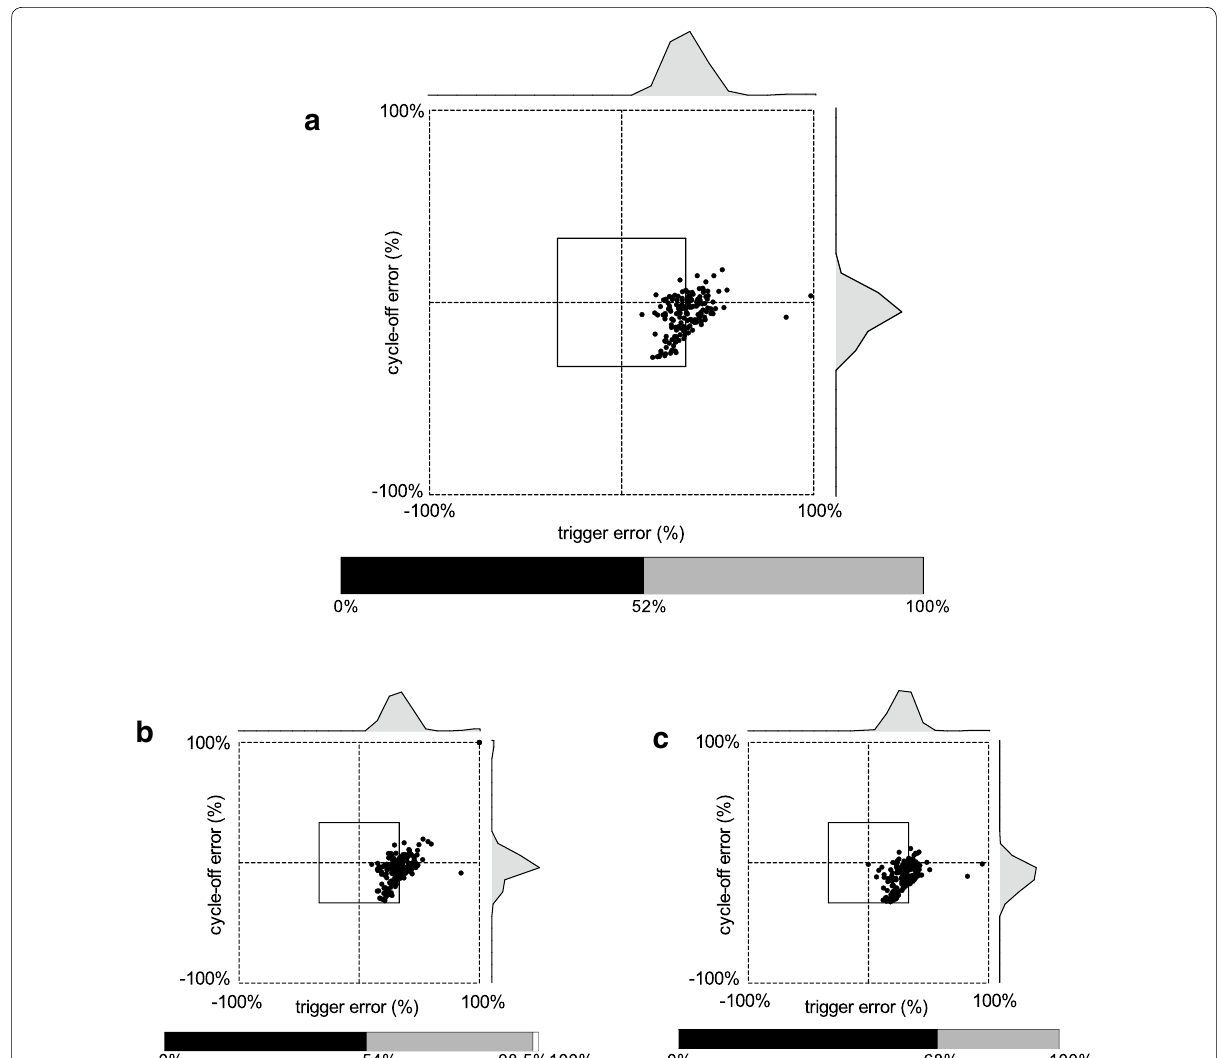
Fig. 4 Example of patient–ventilator interaction diagram with good patient–ventilator interaction. Intra-breath patient–ventilator interaction dia- grams resulting from automated ( a ) and manual analysis by experts 1 ( b ) and 2 ( c ) are shown. Histograms of trigger and cycle-off errors are shown above and right of interaction diagrams. Stacked bar charts showing the relative distribution of events are depicted under the interaction diagrams. Corresponding NA and Paw tracings are shown in Fig.